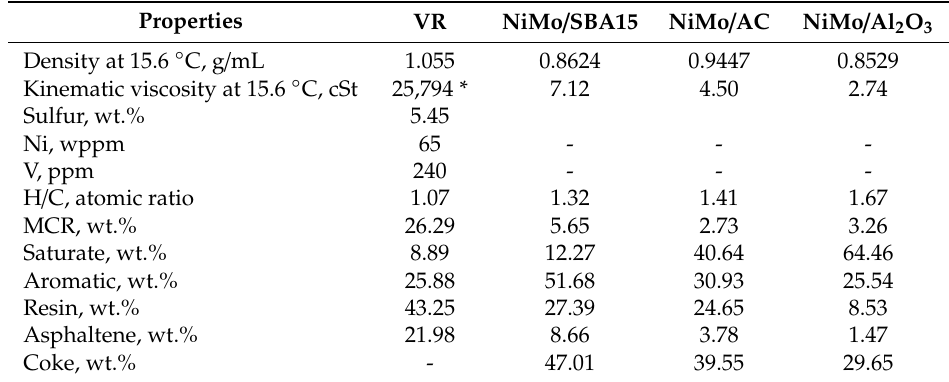
Table 2. Properties of the vacuum residue (VR) feedstock and hydrotreated products.